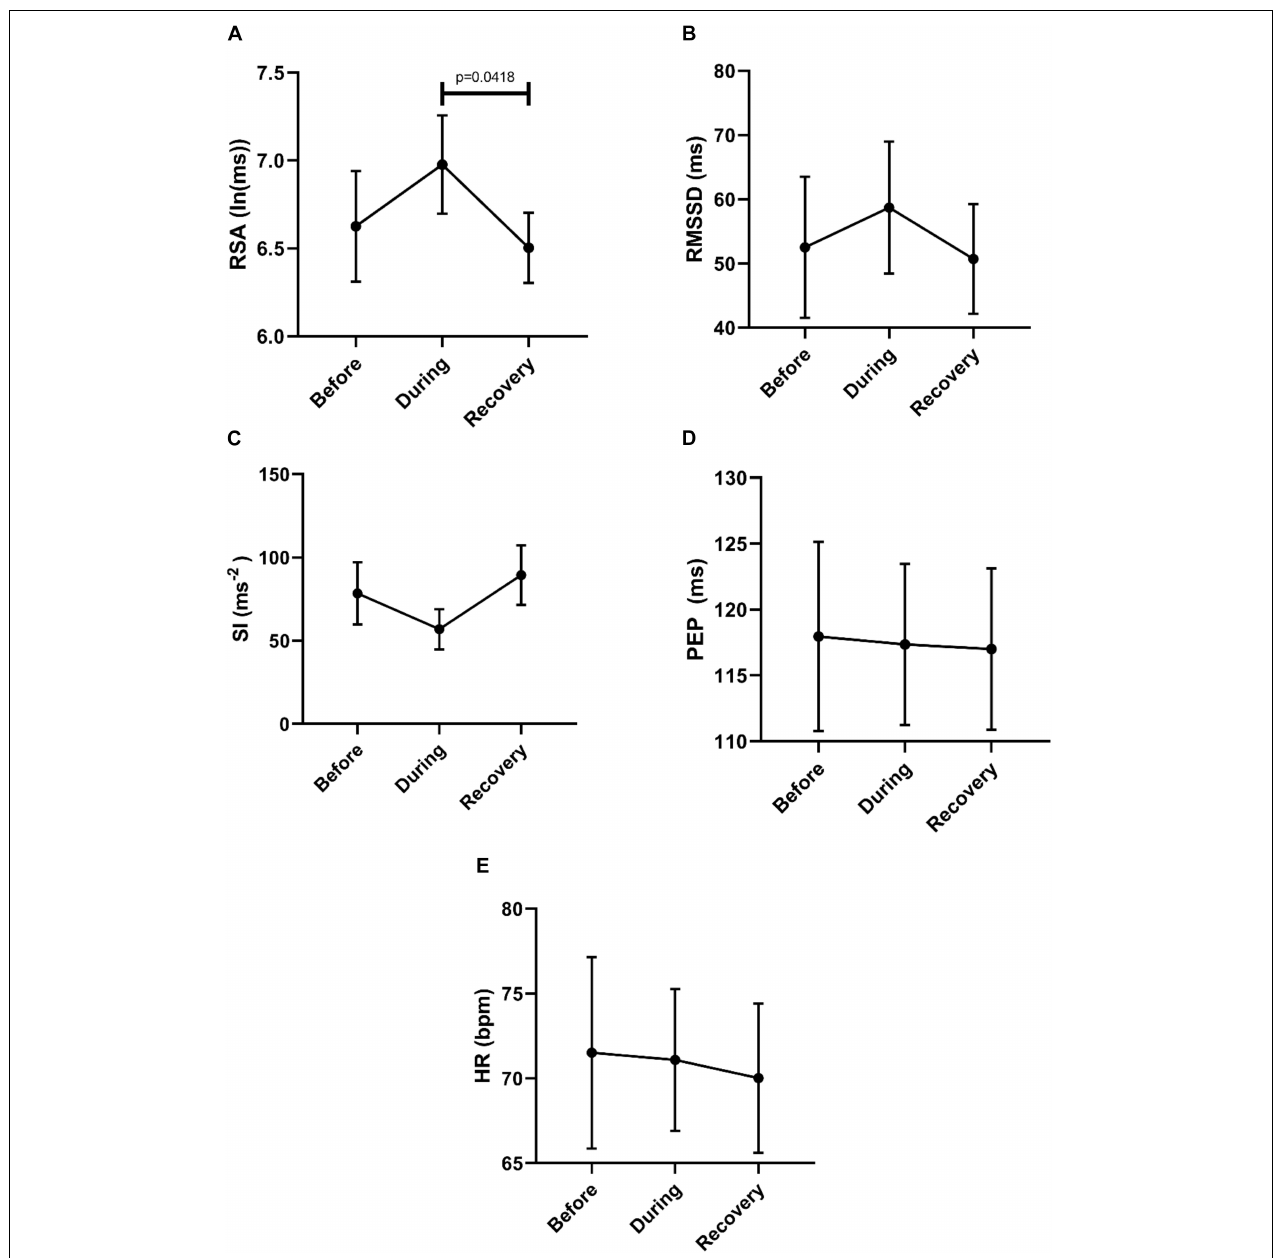
FIGURE 10 | Overall Changes in autonomic activity in response to 30 SPW’s. Data sets were derived by averaging all motor patterns within subjects, hence n = 6. The following HRV parameters were assessed: RSA (A) , RMSSD (B) , the Baevsky’s Stress Index (SI) (C) , PEP (D) , and heart rate (E) . The Friedman test was applied for assessment of significance followed by Dunn’s multiple comparisons test